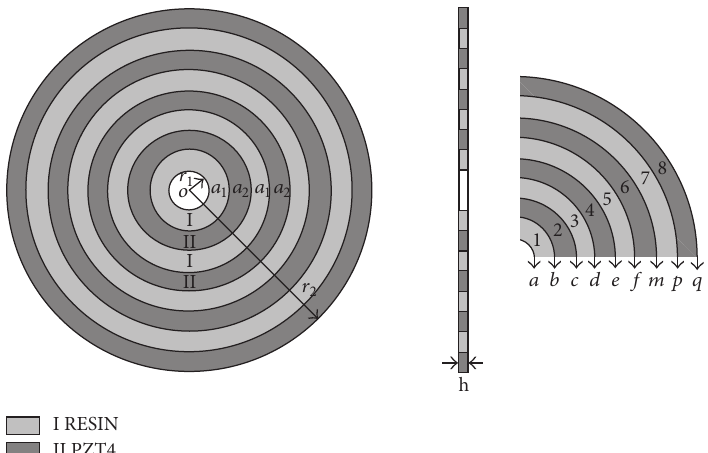
Figure 3: Schematic diagram of radial phononic crystal circular plate.